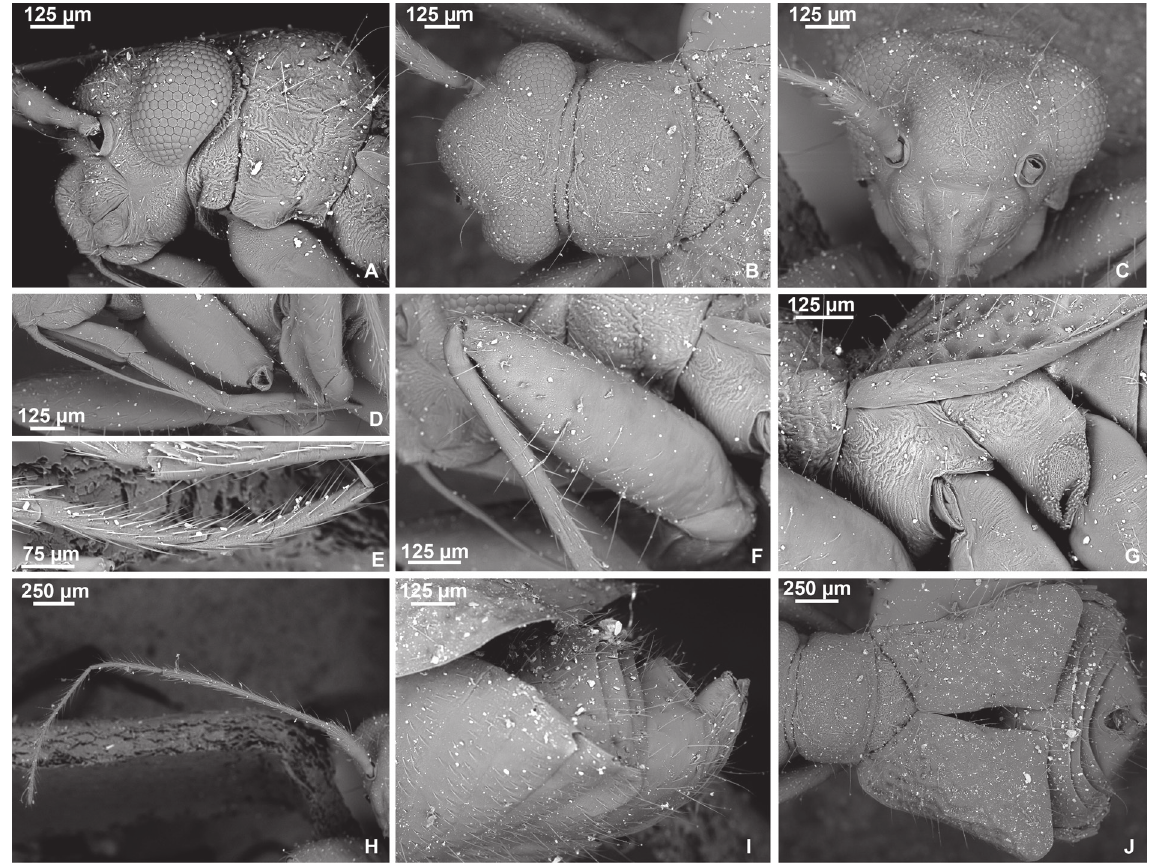
Fig. 5. SEM images of C. taplini Slater & Gross, 1977, ♀. A .Head and pronotum, lateral view. B . Head and pronotum, dorsal view. C . Head, anterior view. D . Labium. E . Hind tarsus. F . Forefemur. G . Pleura. H . Antenna. I . Abdomen, lateral view. J . Pronotum, scutellum, hemelytra and abdomen, dorsal